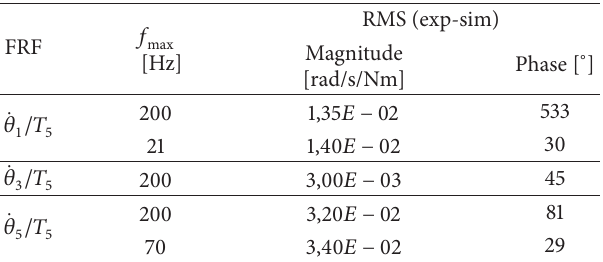
̇𝜃 ̇𝜃 /𝑇 /𝑇 1 5 , 3 5 , and